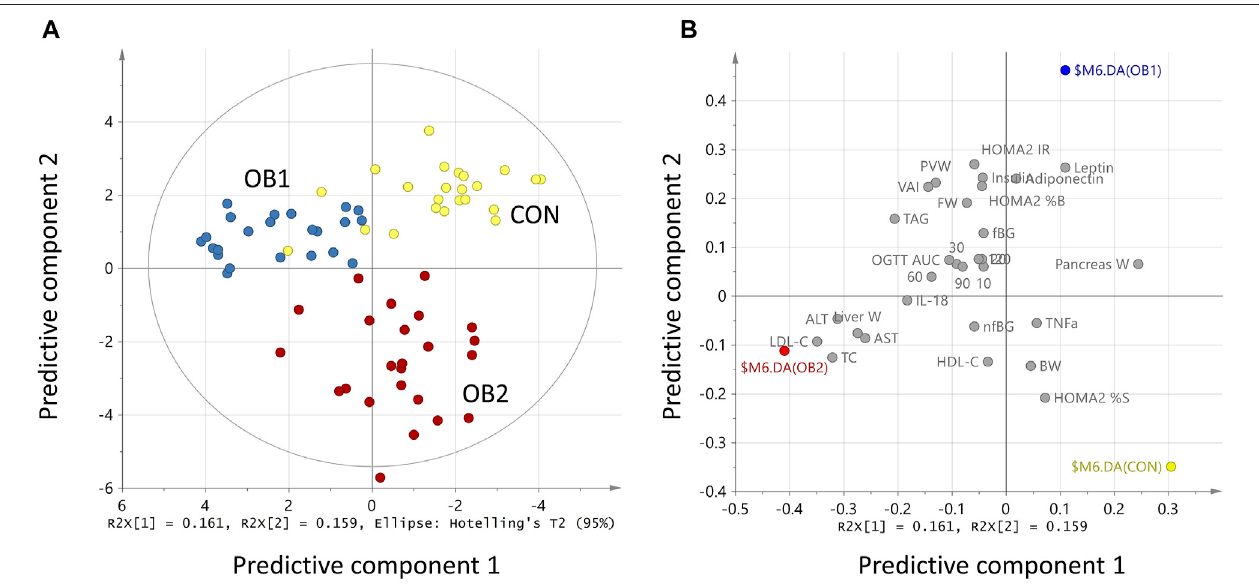
FIGURE 2 | OPLS-DA model scores scatter plot (A) and loadings scatter plot (B) . R2x[1] and R2x[2] indicate the proportion of the variance explained by the fi rst and secondpredictive component, respectively.In (A) ,thecoloureddots(individual rats)indicatedietarygroupmembership,withCON=yellow,OB1=blueandOB2= red.In (B) ,dietarygroupsarerepresentedbycoloureddots(CON=yellow,OB1=blue,andOB2=red)andthemetabolicvariablesbygreydots.Valueswerescaledas proportion to R2X (A) and normalised to unit length (B) .